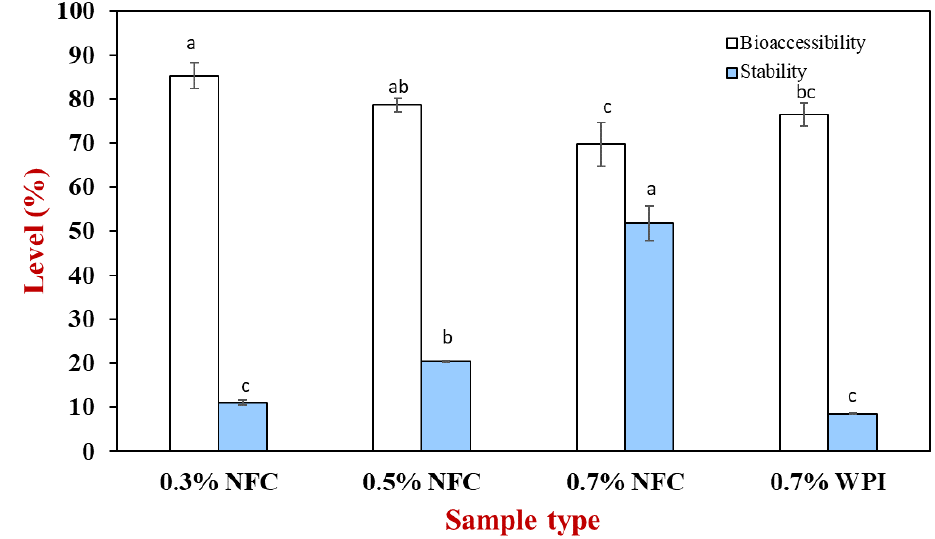
Figure 7. Stability and bioaccessibility in AX-loaded emulsions prepared with NFC and whey protein after undergoing simulated GIT fate. Different lowercase letters (a–c) determine a significant difference in the samples (Tukey, p ≤ 0.05).